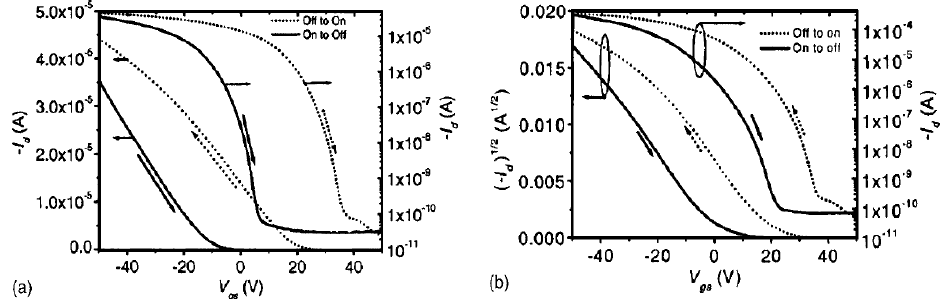
and for ( a ) the linear re- Figure 9 . Transfer characteristics with a device Figure 9. Transfer characteristics with a device L = 50 µ m and W = 1500 µ m for ( a ) the linear gime ( and ( b ) the saturation regime ( , respectively. Reproduced with per- regime ( V d = − 10 V ) and ( b ) the saturation regime ( V d = − 50 V ) , respectively. Reproduced 𝐿𝐿 = 50 μ m 𝑊𝑊 = 1500 μ m 𝑉𝑉 𝑑𝑑 = − 10 V) 𝑉𝑉 𝑑𝑑 = − 50 V)